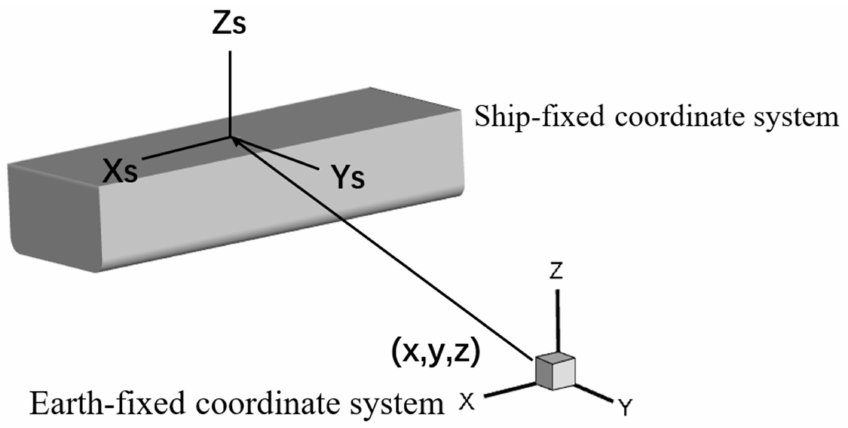
Figure 5. Coordinate